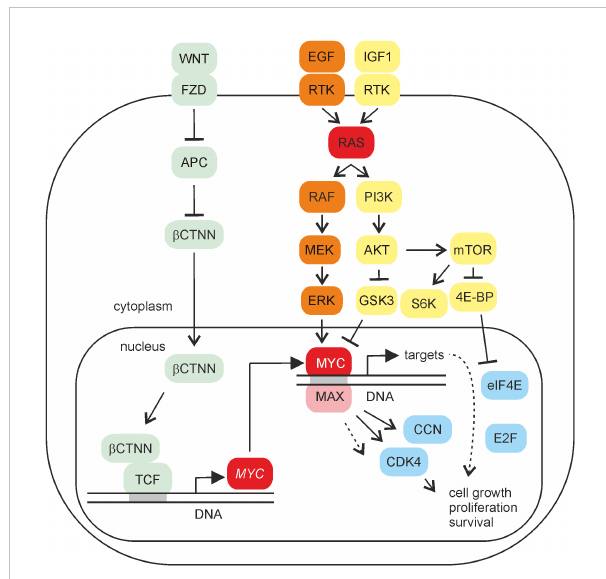
FIGURE 2 MYC signaling. Schematic depiction of selected signaling pathways activating MYC gene and its protein product. Proteins of the WNT, MAPK, or PI3K pathways are shaded in light green, orange, or yellow, respectively. Whereas WNT/ b -catenin signaling leads to transcriptional activation of MYC gene, MAPK or PI3K signaling has an impact on the post-translational modi fi cation of the MYC protein, thereby also in fl uencing its stability. The MYC/MAX heterodimer binds to DNA and regulates the expression of multiple speci fi c target genes. Selected protein products of distinct MYC targets regulating the cell cycle are shaded in